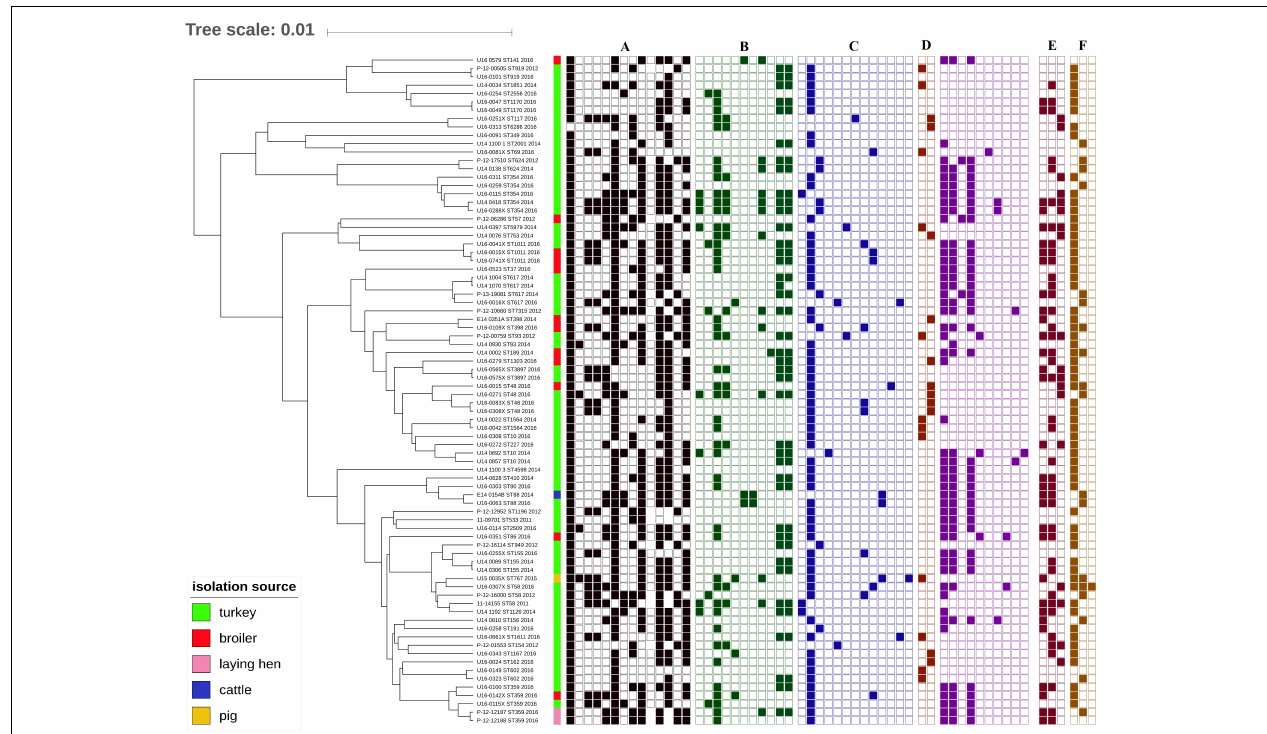
FIGURE 7 | Phylogeny of mcr-1 -positive E. coli (sequence types, year and source of isolation, and map of phenotypic resistance and resistance genes). Full and empty square mean presence and absence of antimicrobial resistance (AMR) gene, respectively, whereas empty space means non-defined or not tested. (A) Resistance profiles (black): ampicillin, azithromycin, cefuroxime, ceftazidime, chloramphenicol, ciprofloxacin, gentamicin, colistin, nalidixic acid, meropenem, sulphonamides, tetracycline, tigecycline, and trimethoprim (Sensititre EUSVEC MIC panel). (B) Aminoglycoside resistance genes (green): aac (3)-IIa, aac (3)-IId, aad A1, aad A2, aad A5, aad A24, aad B, aph (3 (cid:48) )-Ia, aph (3 (cid:48) )-Ic, aph (3 (cid:48)(cid:48) )-Ib, and aph(6) -Id. (C) Beta-lactam resistance genes (blue): bla TEM − 1 A , bla TEM − 1 B , bla TEM − 1 C , bla TEM − 30 , bla TEM − 135 , bla TEM − 52 C , bla CMY − 2 , bla SHV − 12 , bla OXA − 1 , bla CARB − 2 , and bla CTX − M − 1 . (D) Quinolone resistance genes: plasmid-mediated quinolone resistance (PMQR, brown): qnrS1 , qnrB19 ; mutations in quinolone resistance determining regions (QRDR, violet): gyrA S83L, gyrA D87N, gyrA D87Y, parC